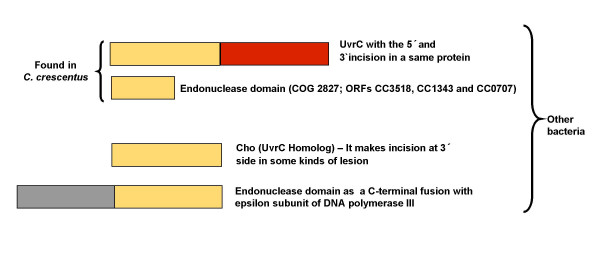
Scheme for the UvrC and UvrC-like proteins. The yellow boxes characterize putative endonuclease domains. In red box is shown the C-terminal domain of UvrC, and in gray box the epsilon subunit of DNA polymerase III.